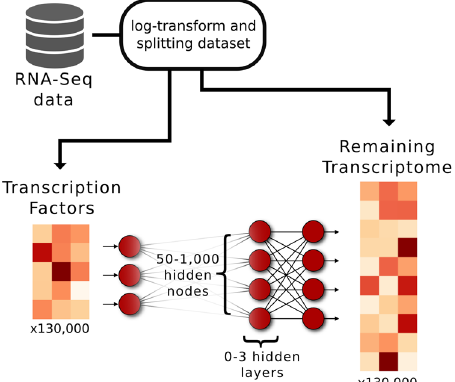
Fig. 1 Design of the arti fi cial deep neural networks. The networks were made to predict the expression of 25,861 genes based on 1,625 gene regulators, i.e. transcription factors (TFs). We used more than 100,000 randomly drawn RNA-seq samples from the ARCHS4 database to train the models. Moreover, we designed 15 DNNs of 1 – 3 hidden layers, and one shallow neural network without any hidden layers. For the DNNs, each hidden layer consisted of either 50, 100, 250, 500, or 1000 hidden nodes using the exponential linear unit, ELU as activation function.